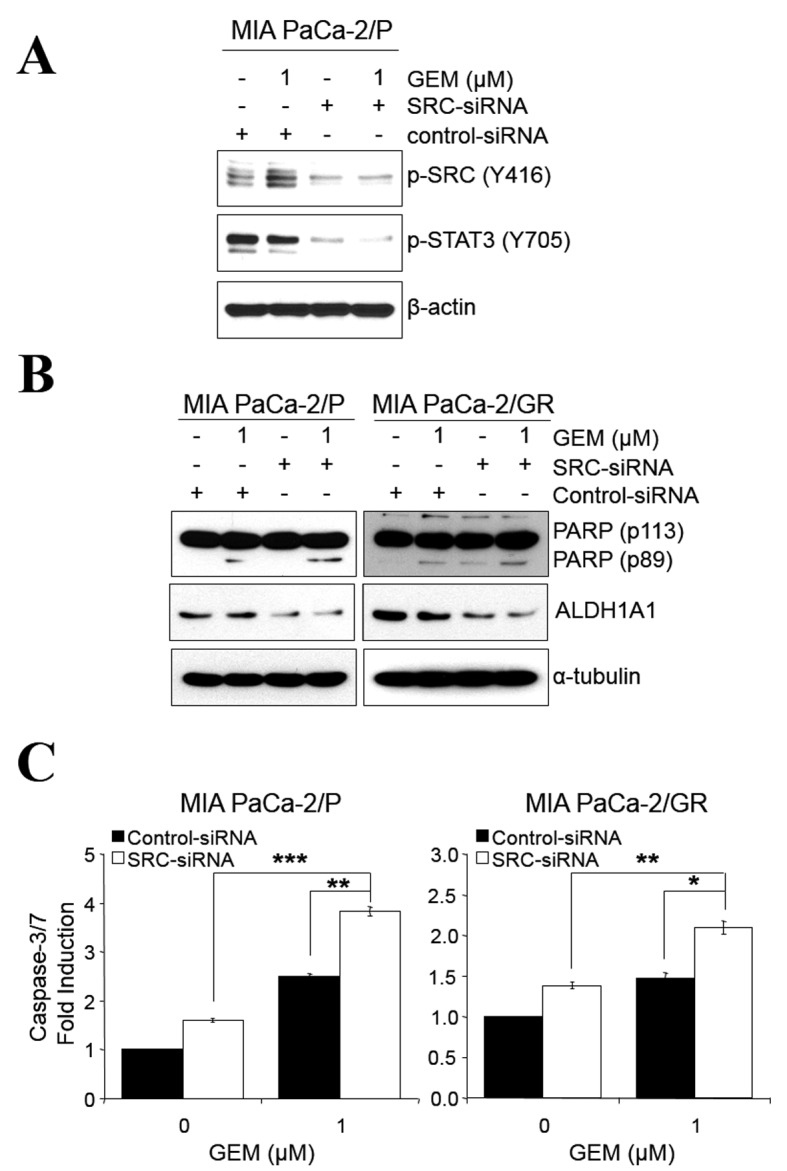
Knockdown of SRC enhances gemcitabine (GEM)-induced apoptotic cell death and reduces the level of ALDH1A1 expression. (A) MIA PaCa-2/P cells were transfected with either SRC-siRNA or control-siRNA for 48 h and further treated with GEM (1 μM) for 48 h. The western blot analysis was conducted to determine the indicated proteins. β-actin was used for a loading and transfer control. (B) The cells were transfected with either SRC-siRNA or control-siRNA for 48 h and further treated with GEM (1 μM) for 48 h and western blot analysis was performed with indicated antibodies. α-tubulin was used for a loading and transfer control. (C) The cells treated as described in (B) were lysed and the caspase-3/7 activities were determined as described in Materials and methods. Representative data are shown as mean ± SD from three independent experiments. *P<0.05; **P<0.01; and ***P<0.005.